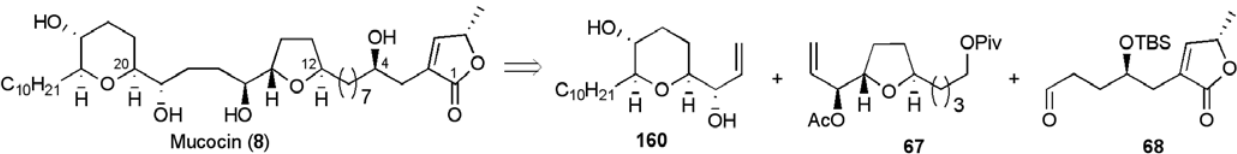
Figure 21. CM and olefination approach to mucocin ( 8 ) used by Mootoo and co-workers